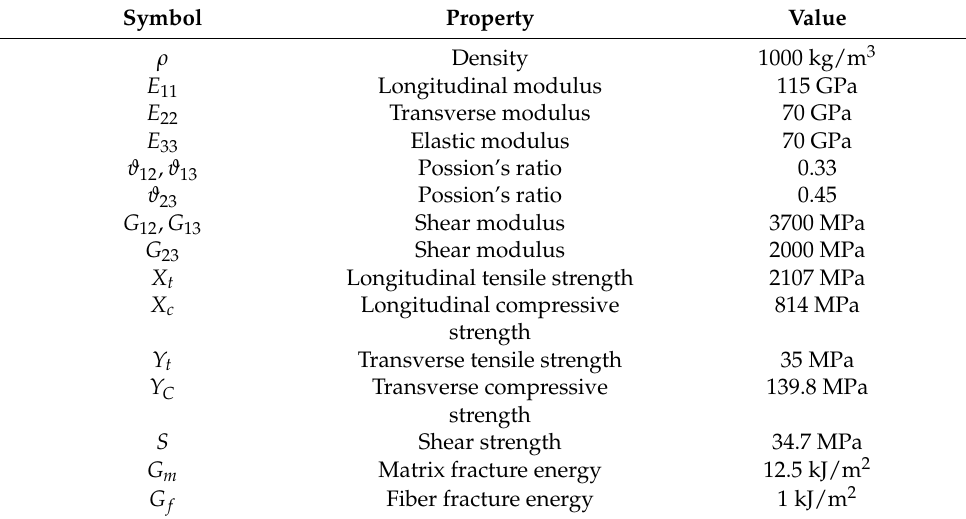
Table 2. Material properties of T700/PA carbon fiber unidirectional